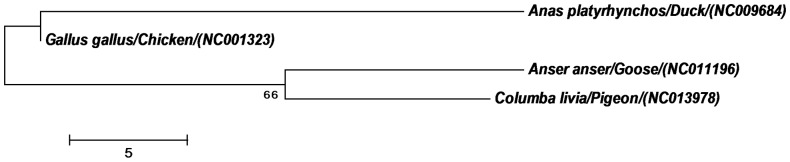
Phylogenetic tree illustrating relationship among the four host species following the neighbour-joining method using MEGA6 software.Parameters include: pairwise deletion, 1000 replicates for bootstrap analysis and Dayhoff substitution model. The reference sequence of the mitochondrial DNA was taken to study the relationship among the host species.